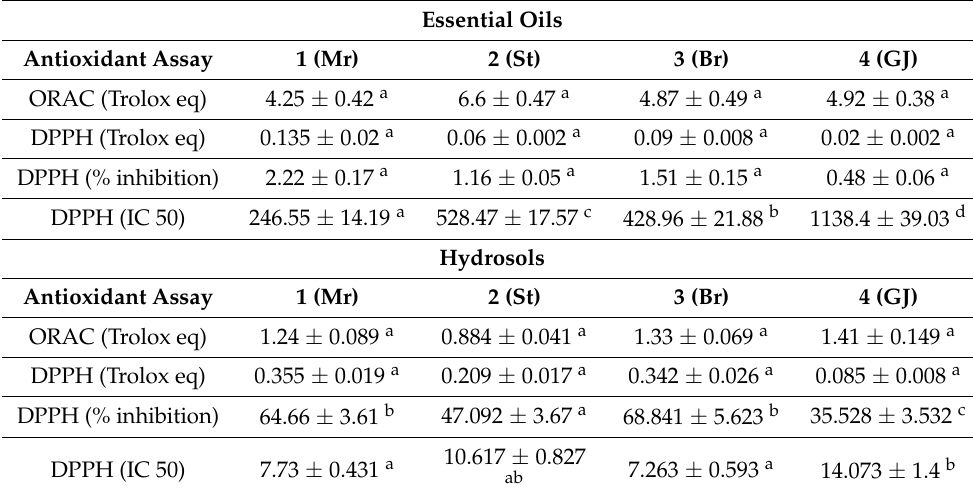
Table 3. Antioxidant potential of V. austriaca ssp. jacquinii of the essential oil and hydrosol determined by ORAC and DPPH method. Essential